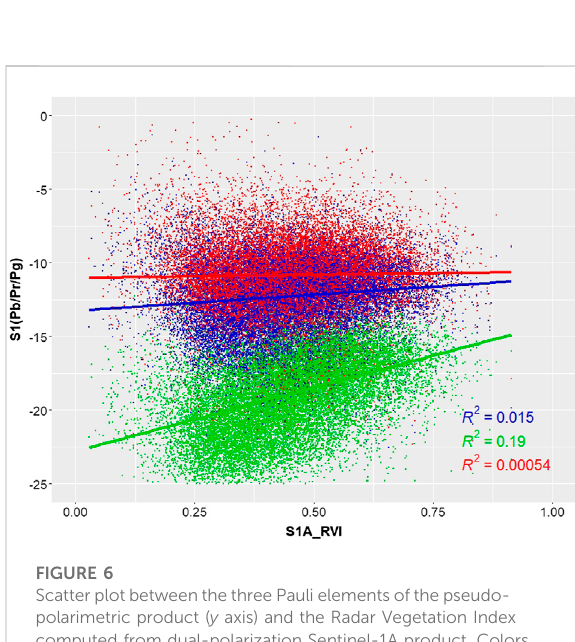
FIGURE 6 Scatter plotbetweenthethree Pauli elements ofthepseudo- polarimetric product ( y axis) and the Radar Vegetation Index computed from dual-polarization Sentinel-1A product. Colors indicate surface (blue), dihedral (red) and volume (green)